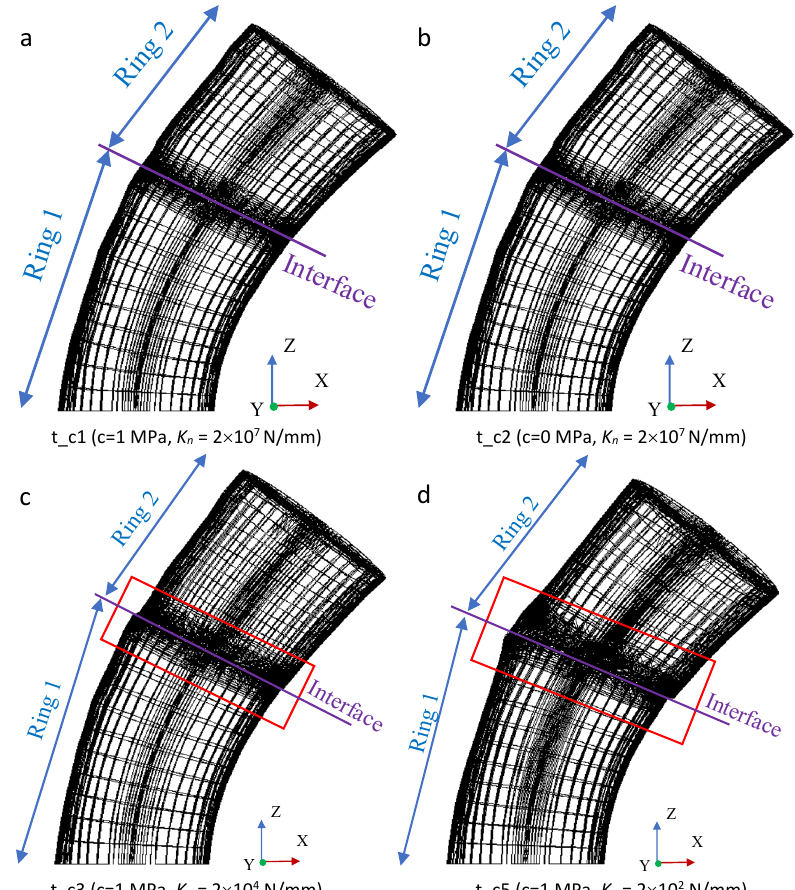
Figure 18. Deformation of models with different cohesive